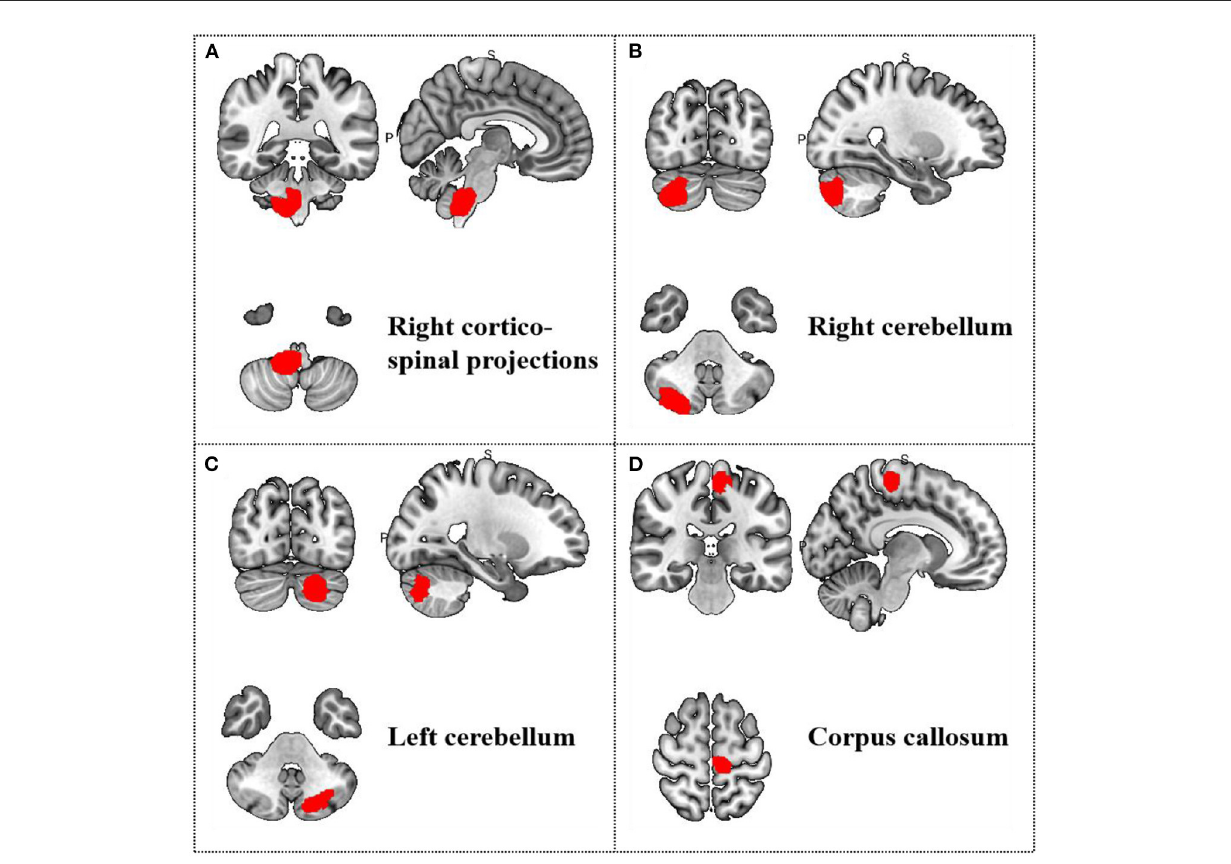
FIGURE6 Results of Meta-regression linear model analysis. Age of migraine patients are positive correlated with regional activity in (A) the right cortico-spinal projections, (B) the right cerebellum, (C) the left cerebellum, and (D) the corpus